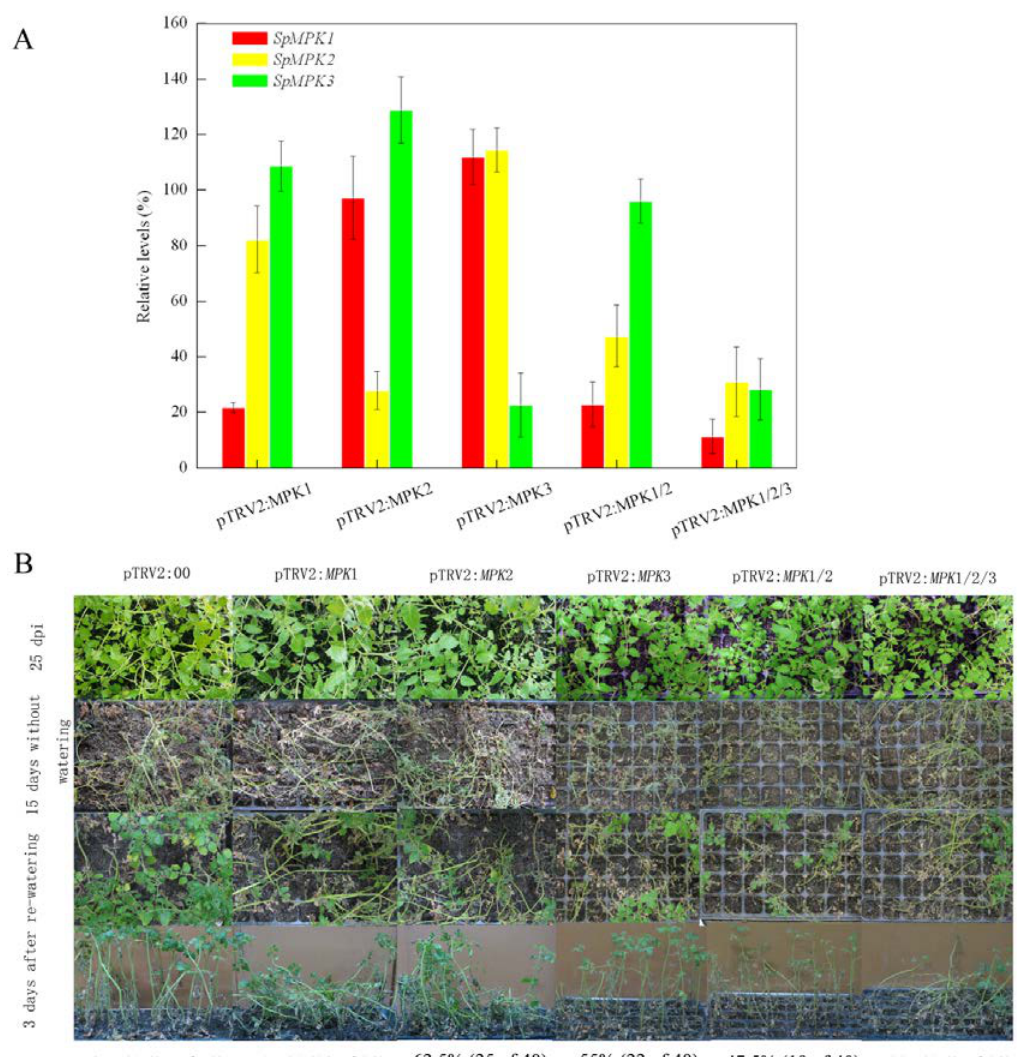
Figure 1. Silencing SpMPK1 , SpMPK2 , and SpMPK3 attenuated the drought tolerance of tomato plants. ( A ) Transcription levels of SpMPK1 , SpMPK2 , and SpMPK3 in each type of gene-silenced plants. Nine to 10-day-old plants were infiltrated